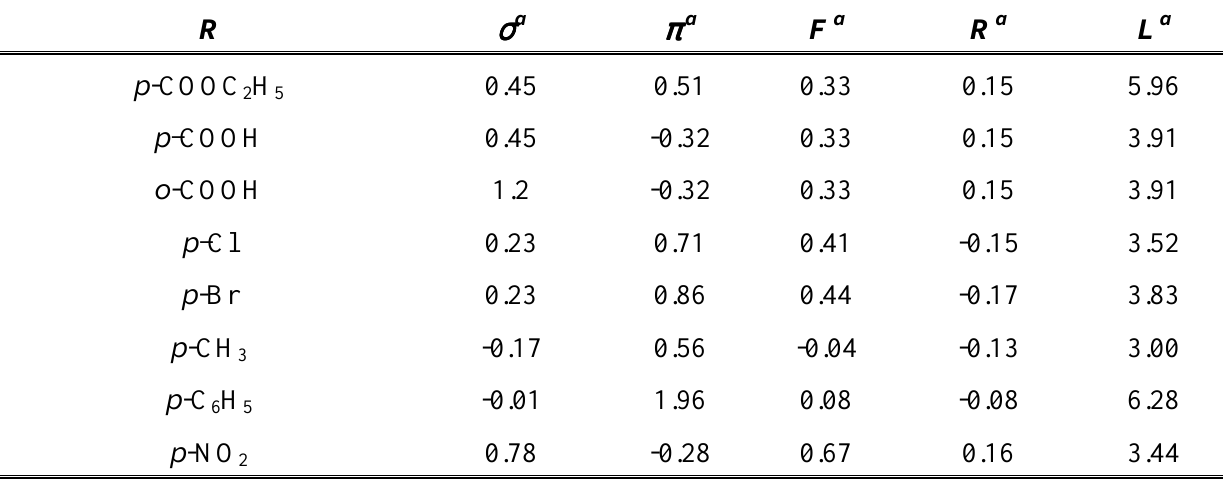
Table 7 : Physicochemical parameters of the triazole derivatives studied